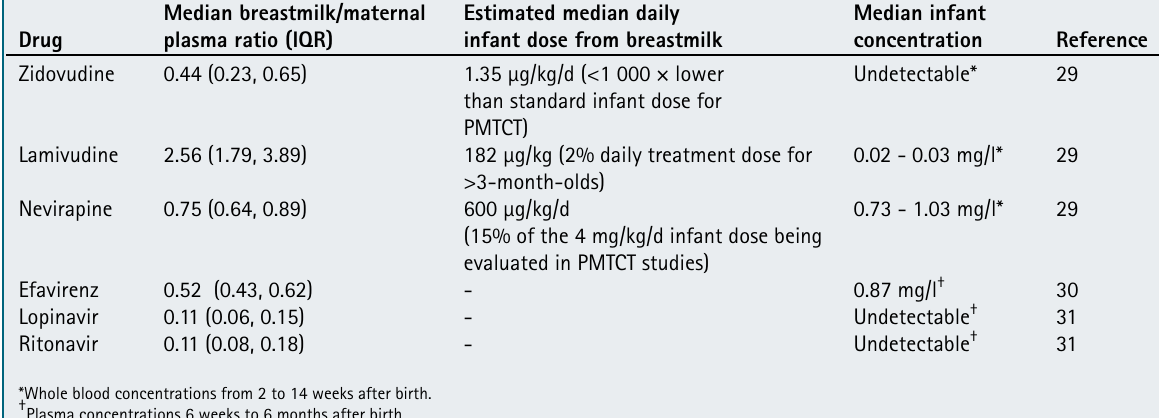
TABLE II. ANTIRETROVIRAL DISTRIBUTION TO BREASTMILK AND INFANT EXPOSURE RESULTING FROM MATERNAL